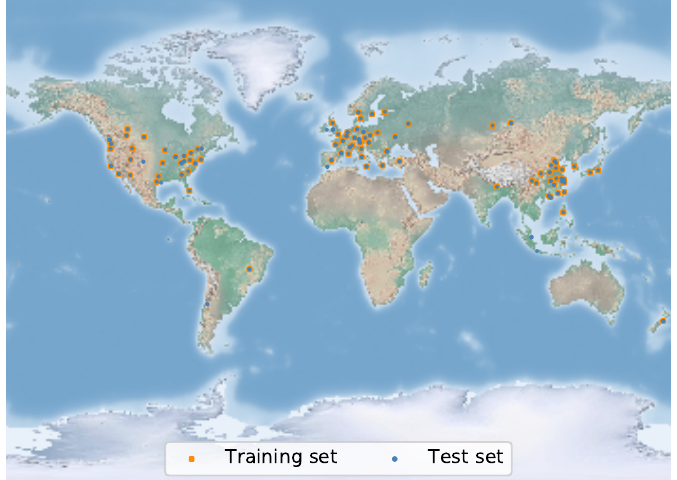
Figure 2. Geospatial distribution of the DREAM-B data set. Each point in this figure represents an image tile. The DREAM-B data set contains 626 tiles in total and covers 100 cities across several